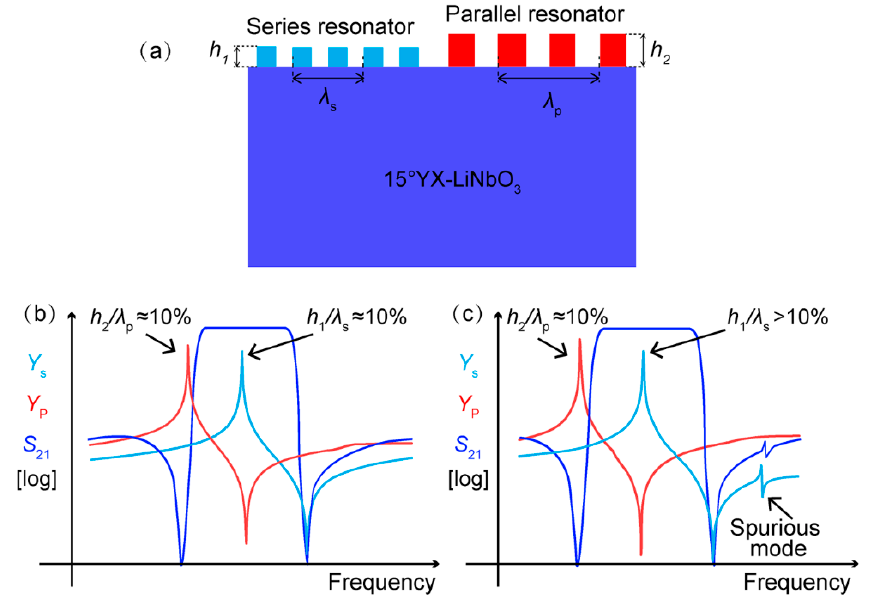
Figure 4. ( a ) Design of thickness-modulated IDT structures in this work. ( b , c ) Schematic diagrams of two thickness-modulated IDT designs.